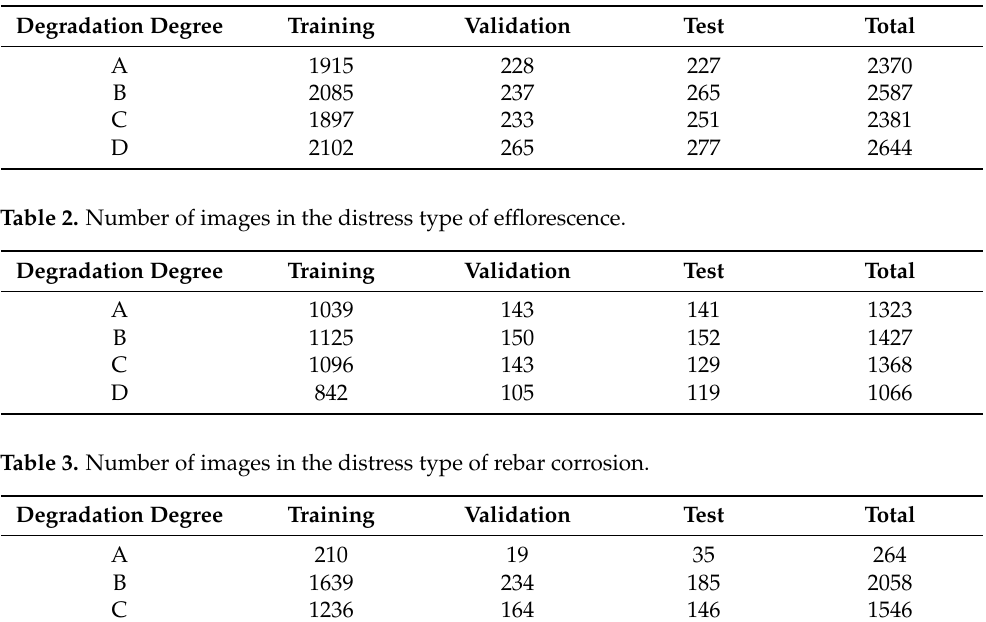
Table 1. Number of images in the distress type of crack.